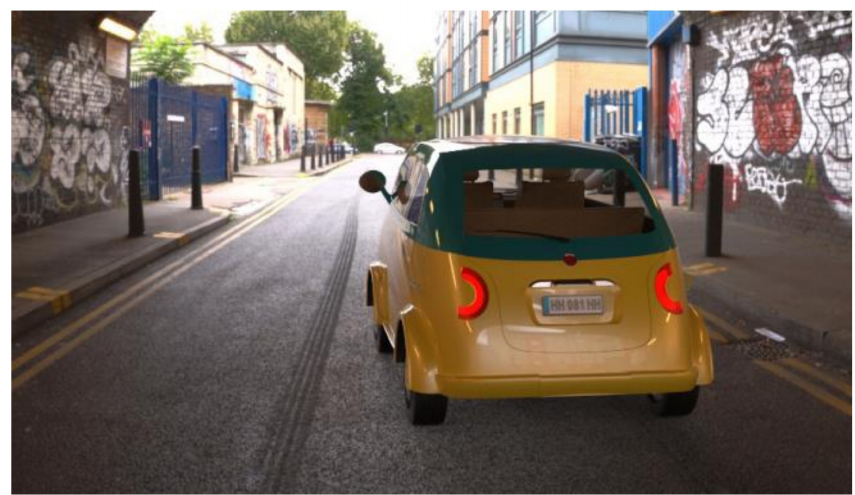
Figure 34. New FIAT 600 Omega—Rendering: City environment.